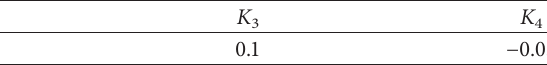
Table 6: Parameters of VSO-FEMS strategy.